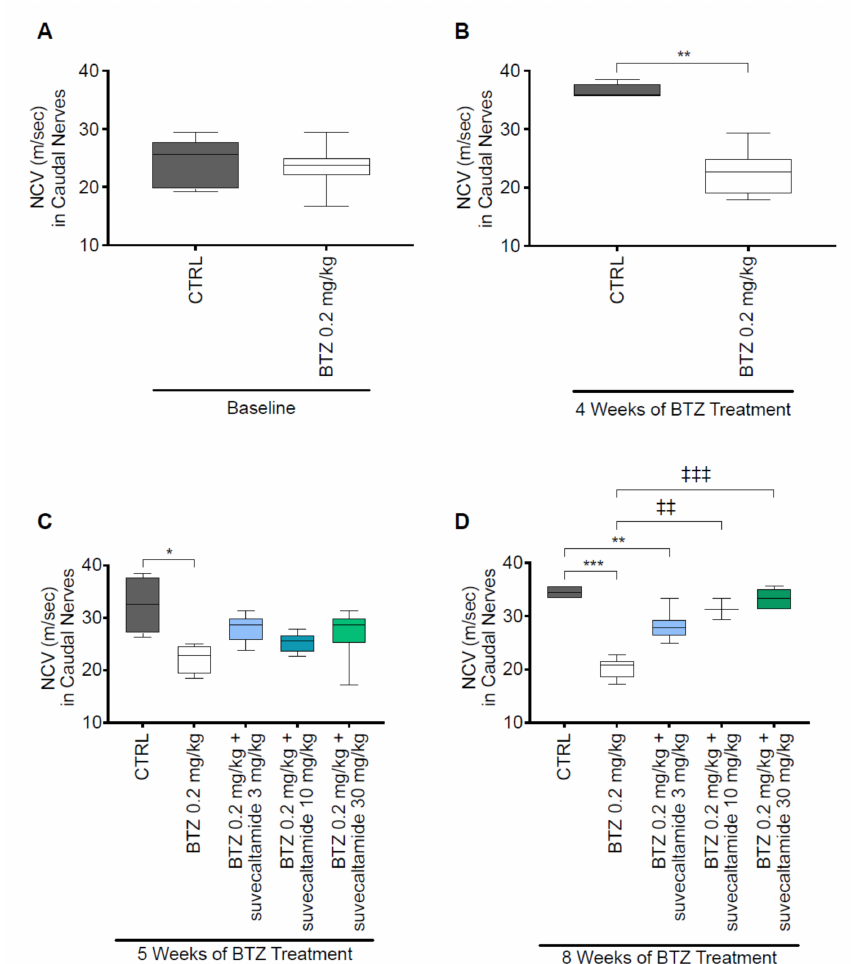
Figure 1. Caudal nerve conduction velocity (NCV). Conduction velocity obtained from caudal nerves by electromyography during phase 1 (( A ) baseline and ( B ) 4 weeks) and phase 2 (( C ) 5 and ( D ) 8 weeks) in a rat model of BTZ-induced CIPN. BTZ—bortezomib; CIPN—chemotherapy-induced peripheral neurotoxicity; CTRL—untreated animals. * p < 0.05 vs. CTRL; ** p < 0.01 vs. CTRL; *** p < 0.001 vs. CTRL; ‡‡ p < 0.01 vs. BTZ; ‡‡‡ p < 0.001 vs.